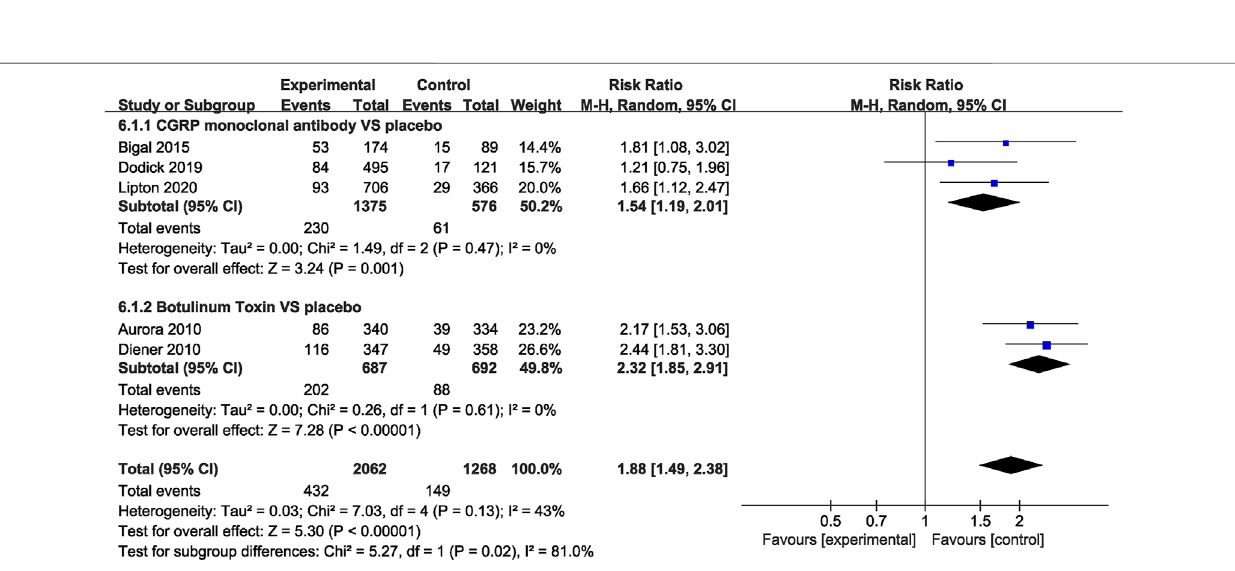
Frontiers in Pharmacology |